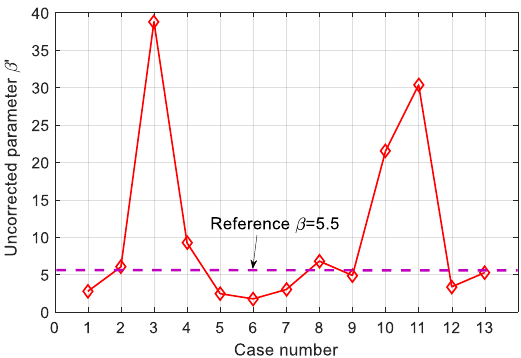
Figure 7. The uncorrected nonlinear parameter, β (cid:48) , calculated using the simulation parameters of Table 2.